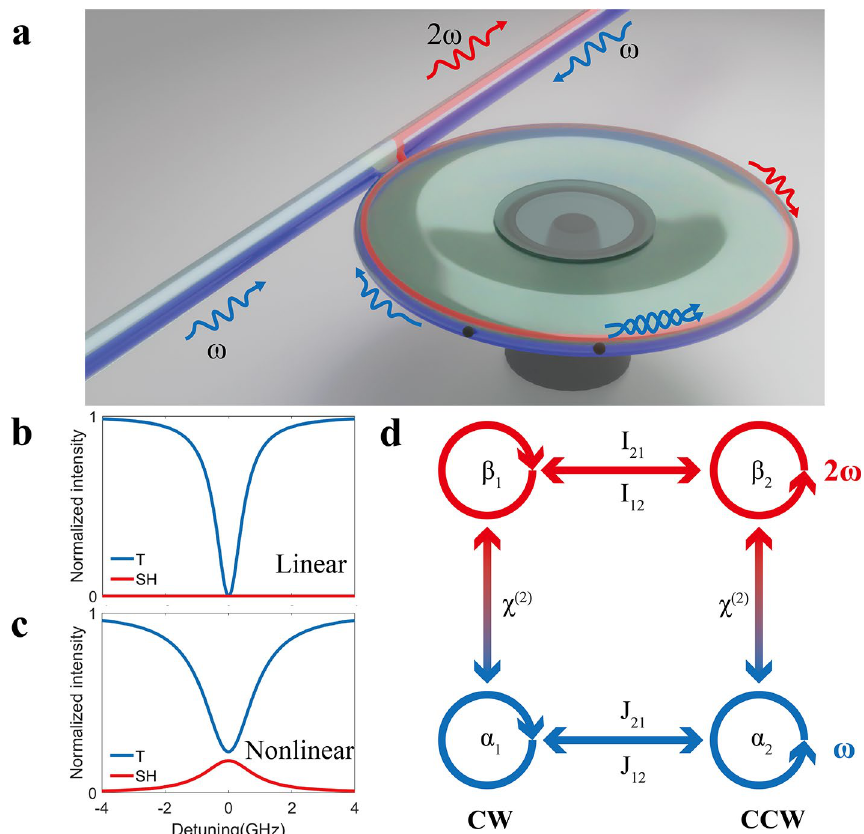
Fig. 1 Illustration of self-induced transparency in a perfectly absorbing optical microcavity. ( a ) Schematic of a tapered fiber coupled lithium niobate microcavity with quadratic nonlinearity, where one-port input is perfectly absorbed inside the microcavity at ( b ) the critical coupling point (theoretical results). Loss factors consist of linear scattering, material absorption, and nonlinear loss through second harmonic generation, which breaks the perfect absorption state and leads to self-induced transparency in ( c ). ( d ) Moreover, the situation becomes more com- plex when both ports are excited by the fundamental waves α 1 (CW) and α 2 (CCW) and their second harmonic waves β 1 (CW) and β 2 (CCW) through the second-order nonlinearity χ (2) . The optical waves in each direction are coupled through the linear scattering processes, i.e., J 12 / J 21 and I 12 / I